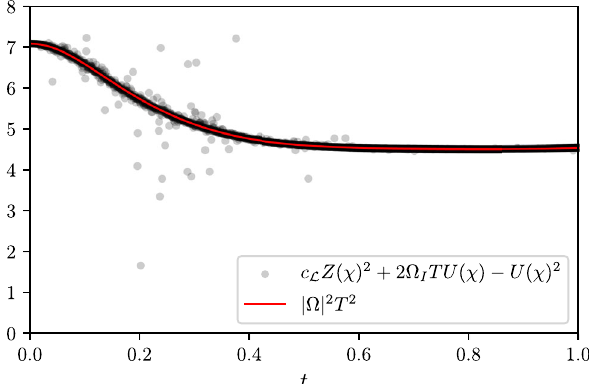
FIG. 5. Numerical confirmation of the singulant equation of motion Eq. (35) along a flow line in the model Eq. (32). This model is distinguished from BRSSS and HJSW by the appear- ance of transverse derivatives in the singulant equation (con- trolled by c L ), a feature it shares with holography and our main motivation for studying it. The values of Z ð χ Þ 2 ; U ð χ Þ ; U ð χ Þ 2 are ð n Þ extracted from the large-order behavior of Π ⋆ and its derivatives, as described in the text. Here the black disks are rendered partially transparent to convey their